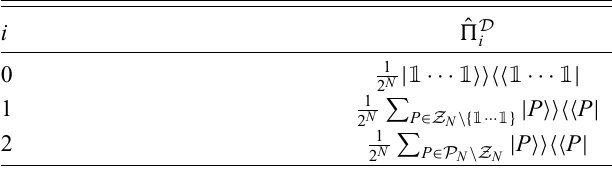
TABLE V. The irreps and projectors of the Liouville represen- tation of D N . For this work, we do not need the characters of D N